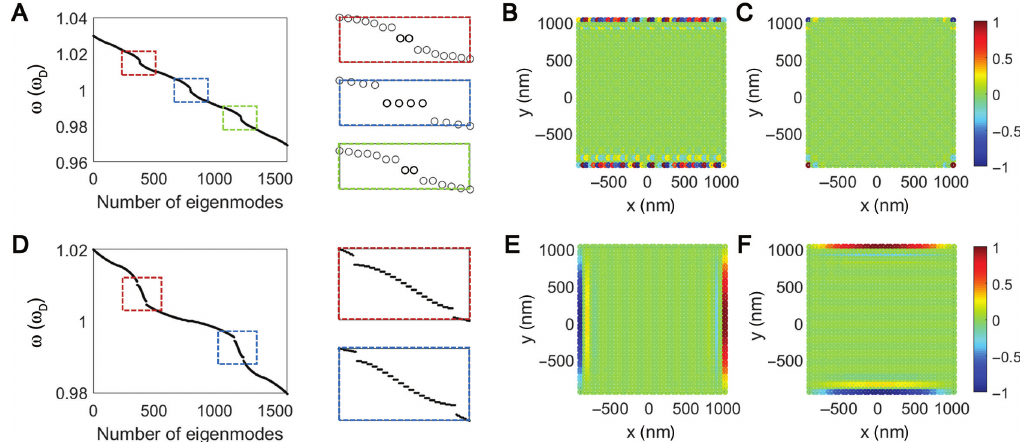
Figure 3: Eigenmodes of an array of 20 × 20 unit cells. (A) Eigenfrequency of x polarization and magnified images of edge (red and green boxes) and corner (blue box) states. Normalized dipole distribution of (B) an edge mode and (C) a corner mode. (D) Eigenfrequency of z polarization and magnified views of edge states. (E) and (F) Normalized dipole distribution of two distinct edge